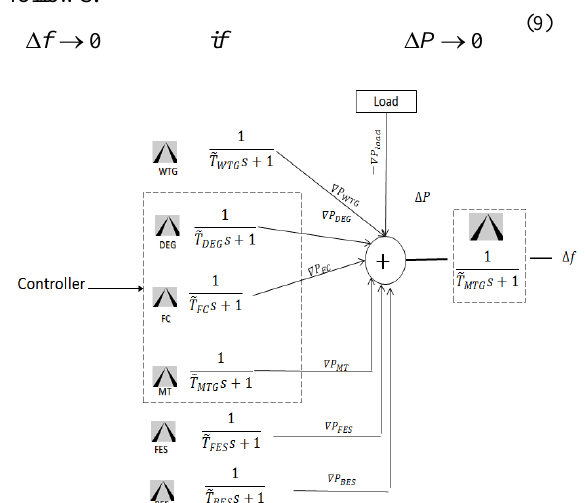
Figure 2. Proposed interval Type II fuzzy dynamical